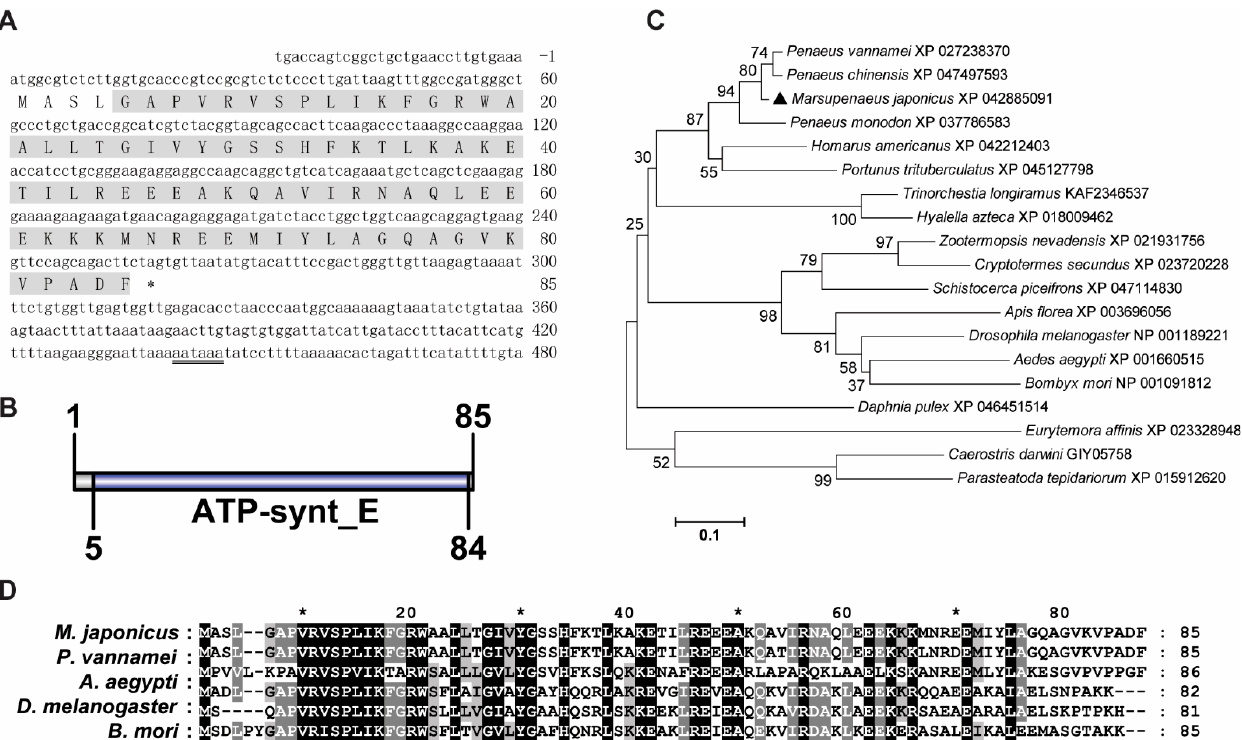
Figure 1. Sequence analysis of Mj ATP5I. ( A ) The nucleotide and deduced amino acid sequence of Mj ATP5I. The letters with a grey background represent the ATP synthase subunit e domain. The double-underlined nucleotides show the polyadenylation signal region. ( B ) The domain schematics of Mj ATP5I. Mj ATP5I contained an ATP synthase E domain with 80 amino acids. ( C ) The phyloge- netic tree analysis of ATP5Is from different animal species, including Aedes aegypti , Amphibalanus amphitrite , Apis florea , Bombyx mori , Caerostris darwini , Cryptotermes secundus , Daphnia pulex , Drosoph- ila melanogaster , Eurytemora affinis , Homarus americanus , Hyalella azteca , Marsupenaeus japonicus , Parasteatoda tepidariorum , Penaeus chinensis , Penaeus monodon , Penaeus vannamei, Pollicipes pollicipes , Portunus trituberculatus , Schistocerca piceifrons , Trinorchestia longiramus , and Zootermopsis nevadensis . Mj ATP5I is marked by a solid black triangle. All of the amino acid sequences were obtained from GenBank. ( D ) Multiple sequence alignment of ATP5Is from M. japonicus , P. vannamei, A. aegypti , D. melanogaster, and B. mori . The conserved sites are labeled by white letters with a black background.